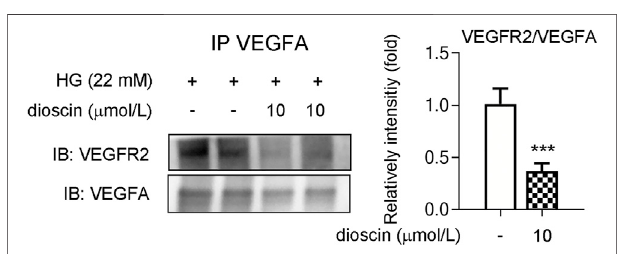
FIGURE 3 | Dioscin inhibits the interaction between VEGFA and VEGFR2. HRMECs treated with dioscin as indicated in panel A. Equal amounts of protein were subjected to immunoprecipitation with VEGFA antibody, followed by immunoblotting with antibody against VEGFR2. Thequantitativeresultsareshownintherightpanel, n (cid:1) 3.*** p < 0.001vs. the control group by Student ’ s t